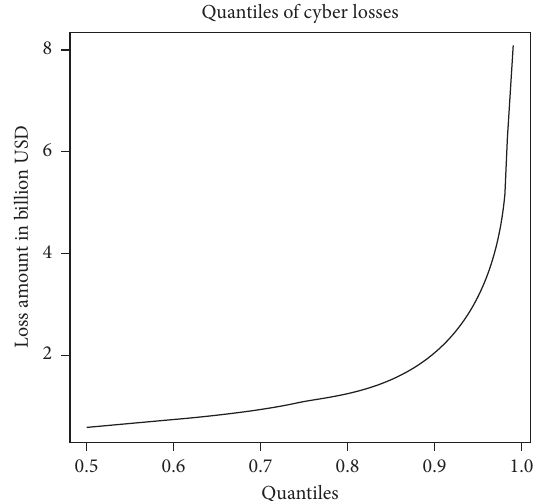
Figure 15: Quantiles of cyber losses for the period of 3years.